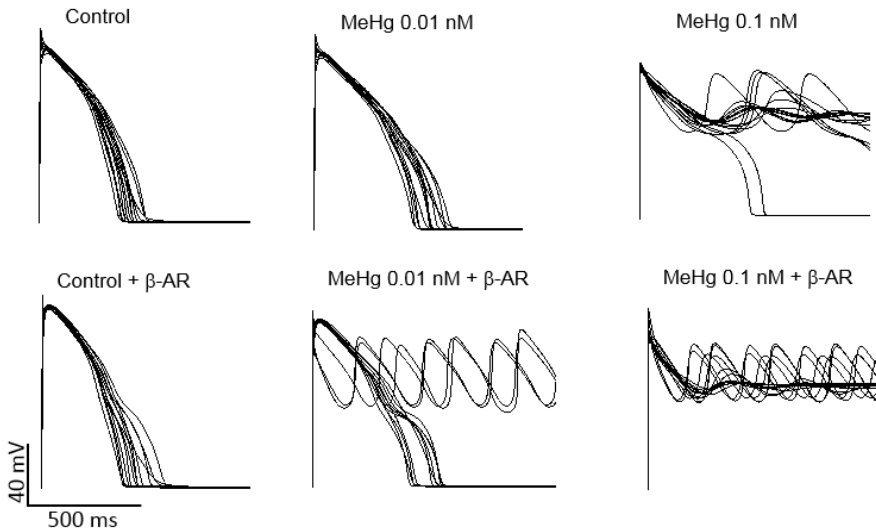
Figure 5. Modeling the effects of acute MeHg-induced changes in ion currents on human ventricular action potential. Computational models were generated to simulate action potential of 100 control individuals in resting conditions and under β -adrenergic stimulation. For clarity, only the first 15 traces are shown. When the ionic conductances were changed to simulate the effects of 0.01 nM MeHg AP duration increases in resting conditions, but after β -adrenergic stimulation, 33% of action potentials generated early afterdepolarizations and arrhythmia. When the ionic conductances were changed to simulate the effects of 0.1 nM MeHg 98% models showed early afterdepolarizations (EADs) and arrhythmia in resting conditions and 100% after β -adrenergic stimulation.